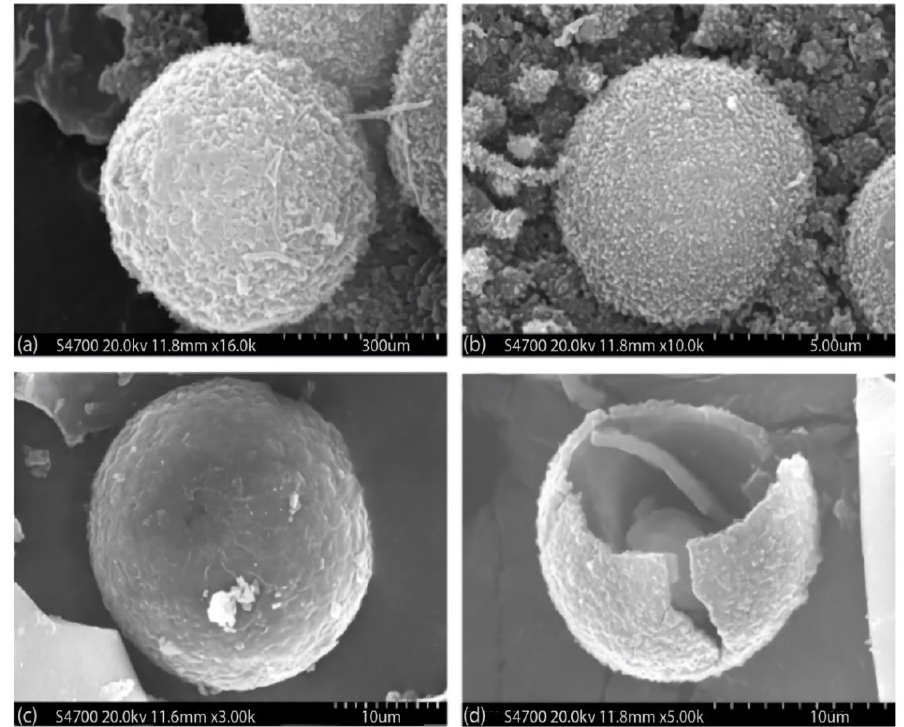
Figure 12. SEM images of micro-encapsulated PCMs using different monomers: ( a ) ethylene diamine (EDA), ( b ) toluene-2,4-diisocyanate (TDI), ( c ) Jeffammine and ( d ) a cracked microcapsule [106].